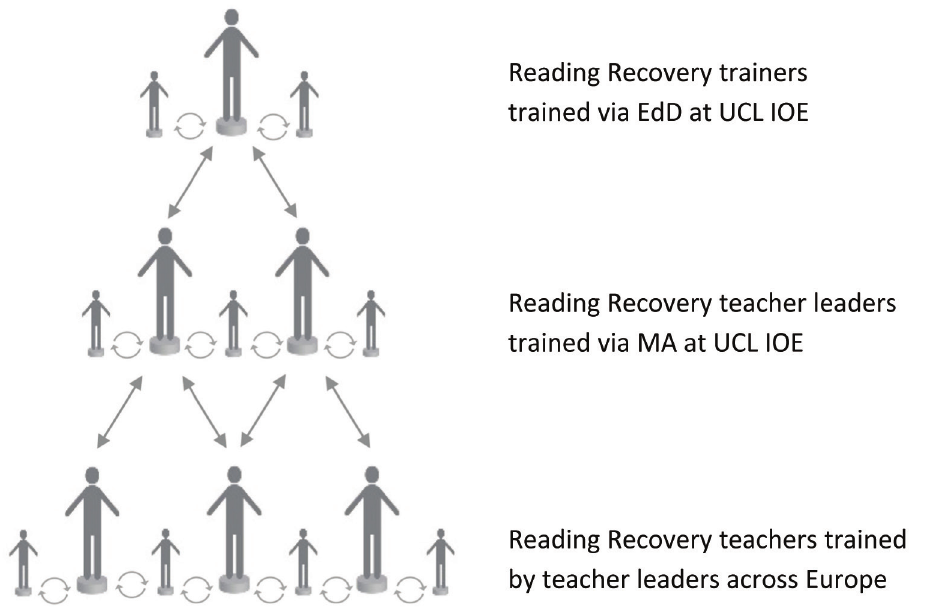
Figure 1: The relationship between Reading Recovery professionals Source : Adapted from Taylor et al. ,